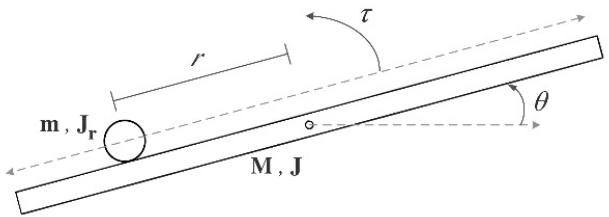
Figure 1. Three ‐ dimensional graphic of ball and beam system DS SolidWorks ® , 2020 SP5.0 Pre ‐